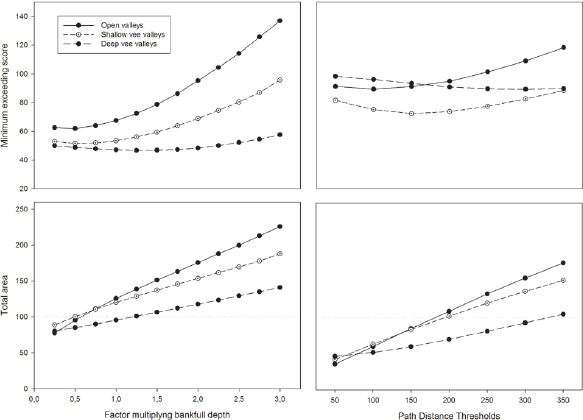
Fig. 9. Values obtained for the two different methods used to evalu- ate the adjustment between geomorphological surfaces and the 50- yr flood when using a 10-m DEM. Arrows indicate optimal thresh- old values (best adjustment) for each geomorphological approach and valley type.